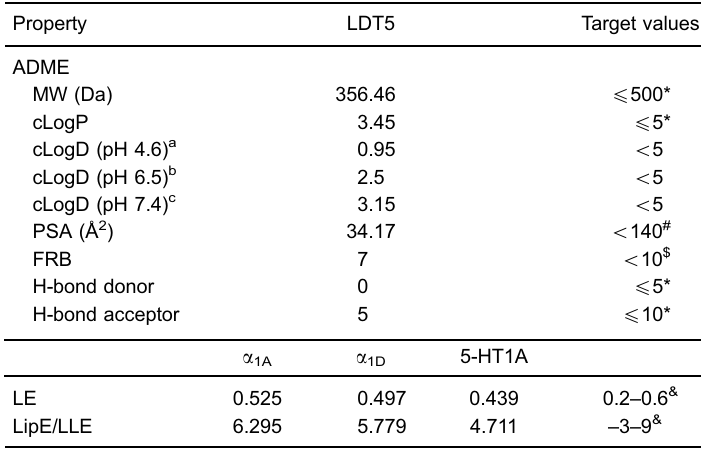
Table 1. In silico ADME and ligand ef fi ciency parameters for LDT5.